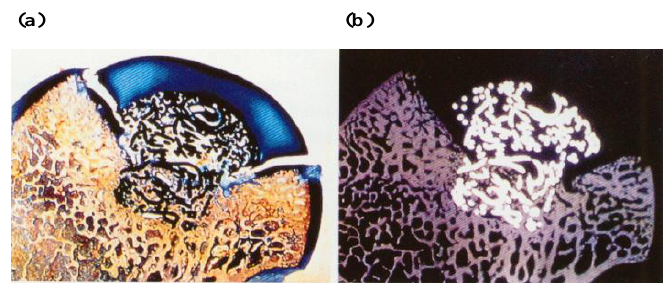
Figure 14. Cross-section view of a specimen of canine femoral head with a composite osteochondral device at 12 months after implant operation (×2.5). (a) Histological appearance (Giemusa stain ). (b) Contact microradiograph